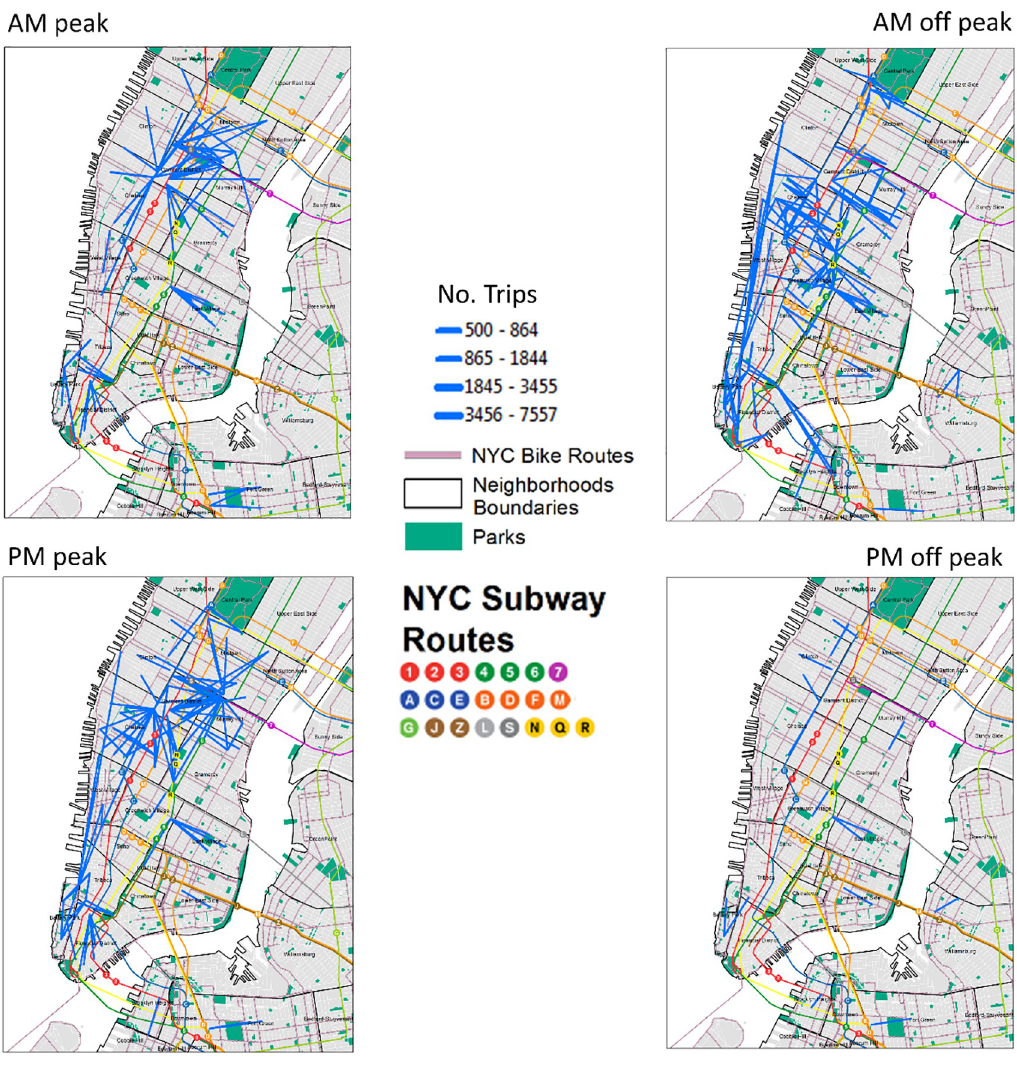
Fig 6. CitiBike usage at different times of the day (peak morning (AM peak) and afternoon (PM peak); non-peak morning (AM off peak) and afternoon (PM off peak)). Maps show routes with more than 500 trips. (Data Sources: NYC Parks, Census Blocks, NYC Neighborhood Names, Subway Entrances and Routes, NYC Bike Routes (S2